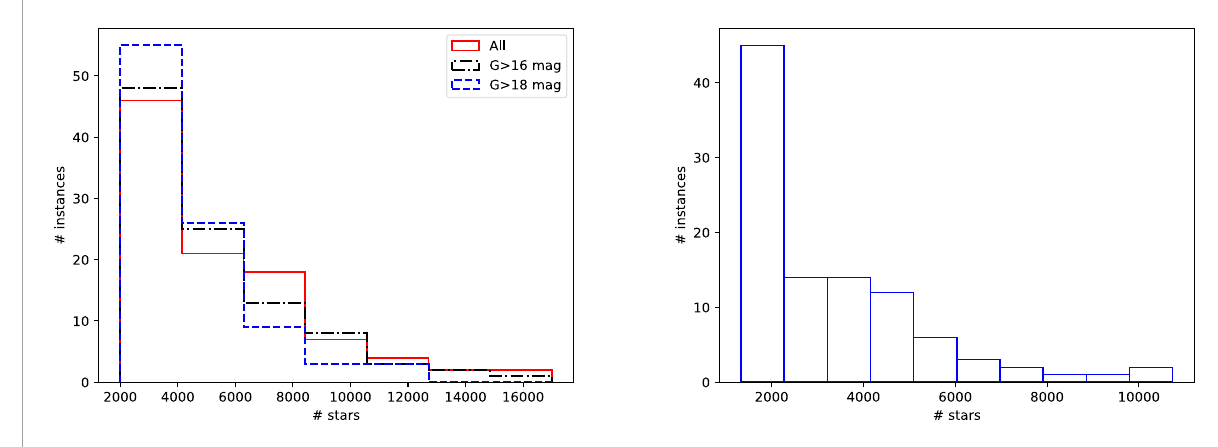
FIGURE 3 Histograms of number of fields populated with a given Gaia source density. Left: total DR3 population (red solid line), reduced by cutting to bright CSST-OS limiting magnitude G = 16 mag (black dashed-dotted line) and G = 18 mag (blue dashed line). Right: density of five- or six-parameter DR3 sources in the selected fields.